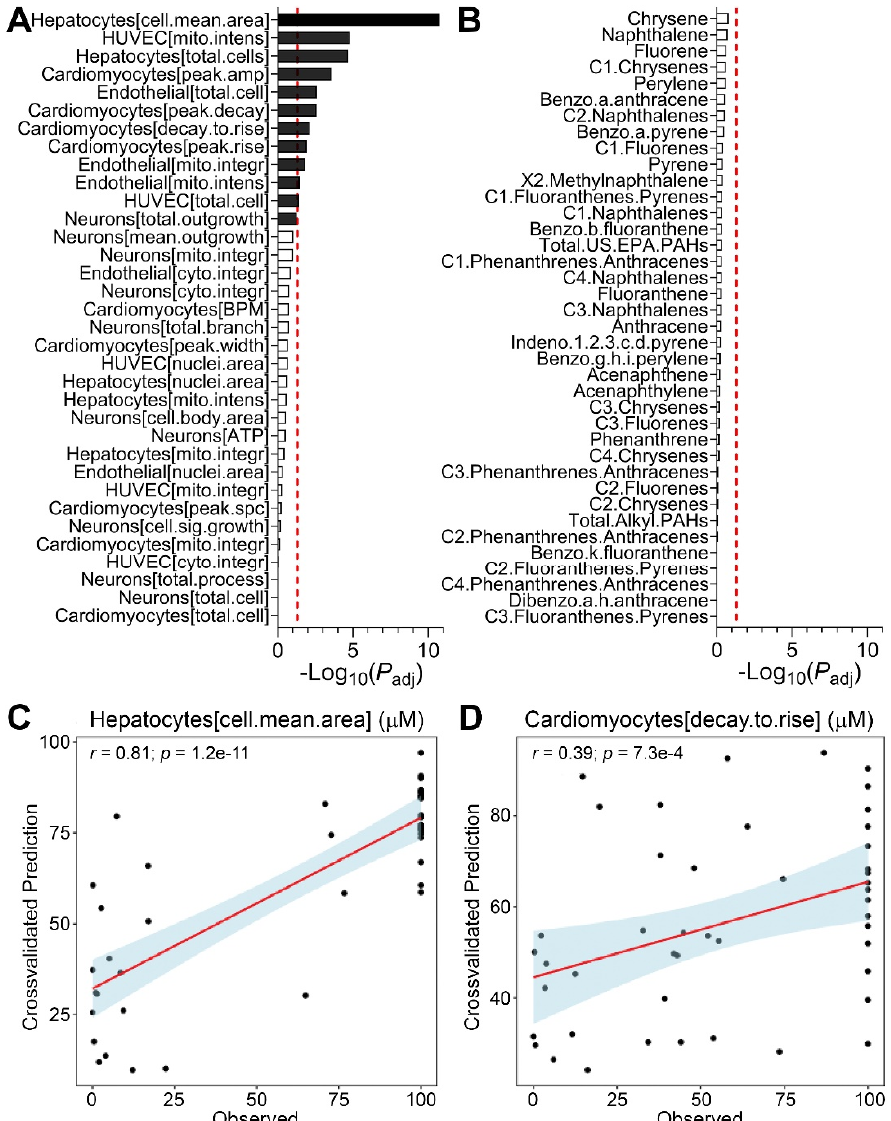
Figure 5 . Cross-validated prediction of in vitro bioactivity and PAH concentrations. Significance of prediction for in vitro bioactivity data from PAH levels ( A ), or vice versa ( B ) is expressed as p adj values (false discovery adjustment was performed using the Benjamini-Hochberg method). Significant results ( p adj < 0.05, vertical red dashed line) are shown as black bars. Also shown are illustrative cross-validated regression predicted values (y-axis) versus actual values (x-axis), for predicting ( C ) “cell.mean.area” phenotype in iCell hepatocytes, or ( D ) “decay.to.rise” phenotype in iCell cardiomyocytes. Dots are samples, red line is linear regression and blue shaded areas are 95% confidence intervals. Regression coefficients ( r ) and associated adjusted p -values are indicated.